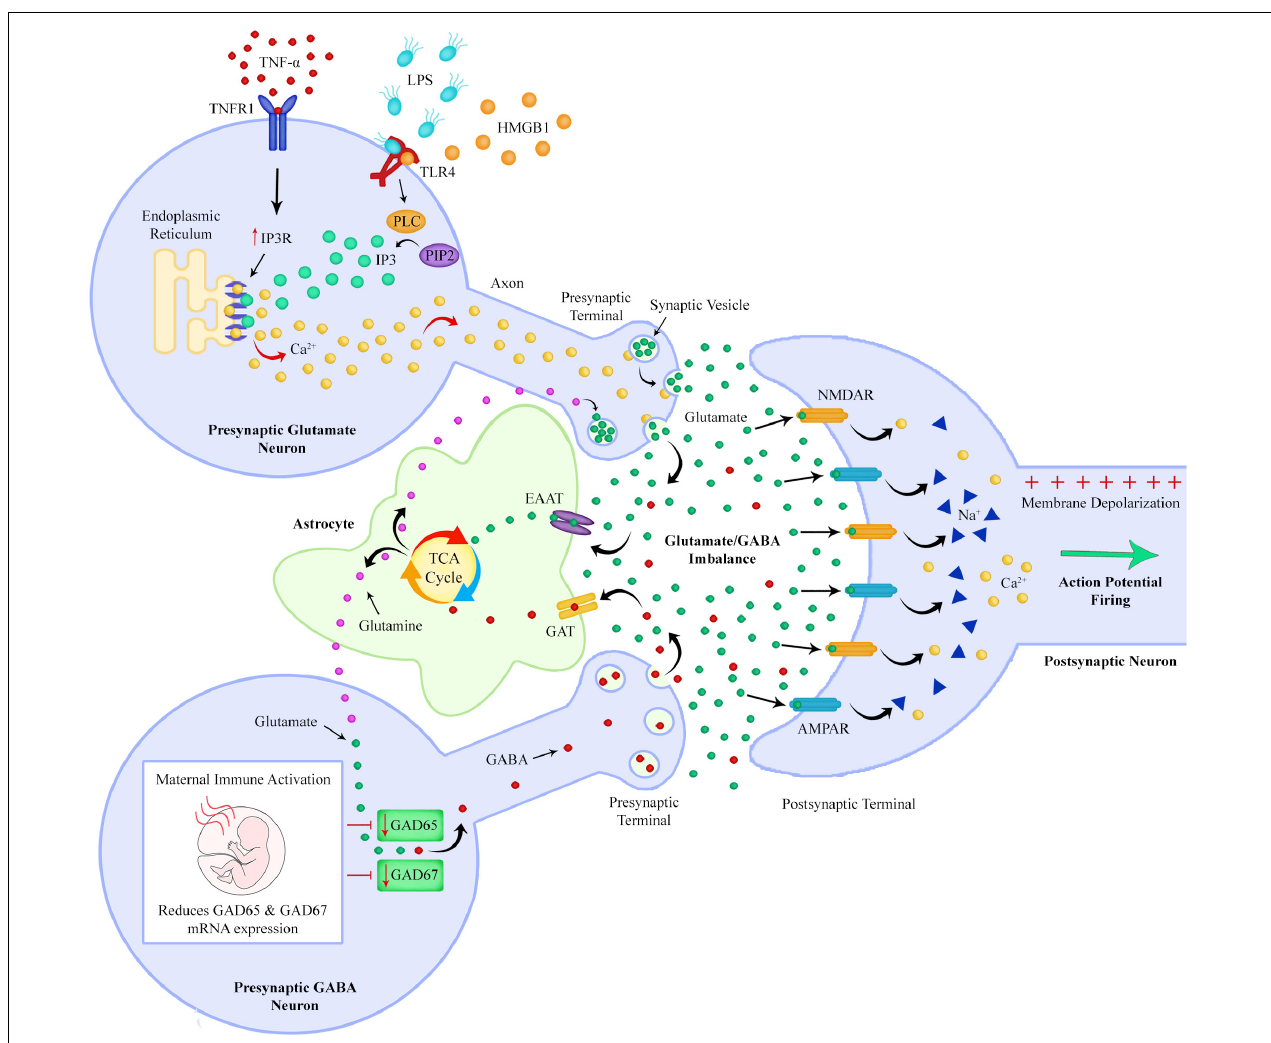
FIGURE 6 | After passing the blood brain barrier, TNF- α can bind to TNF receptors on neurons resulting in an increased expression of IP3 receptors on the endoplasmic reticulum. LPS binds to TLR4s on neurons and can increase levels of IP3 by increasing PLC mediated cleavage of PIP2 to DAG and IP3. The combination of increased IP3 and IP3 receptors could lead to an excessive release of calcium from the endoplasmic reticulum, with a subsequent large increase in glutamate release into the extracellular space. If GABA synthesis is reduced due to prenatal maternal immune activation reducing expression of GAD, there could be a resultant imbalance of extracellular GABA and glutamate levels. A GABA/glutamate imbalance could lead to unsynchronized and hyperexcitable neuronal